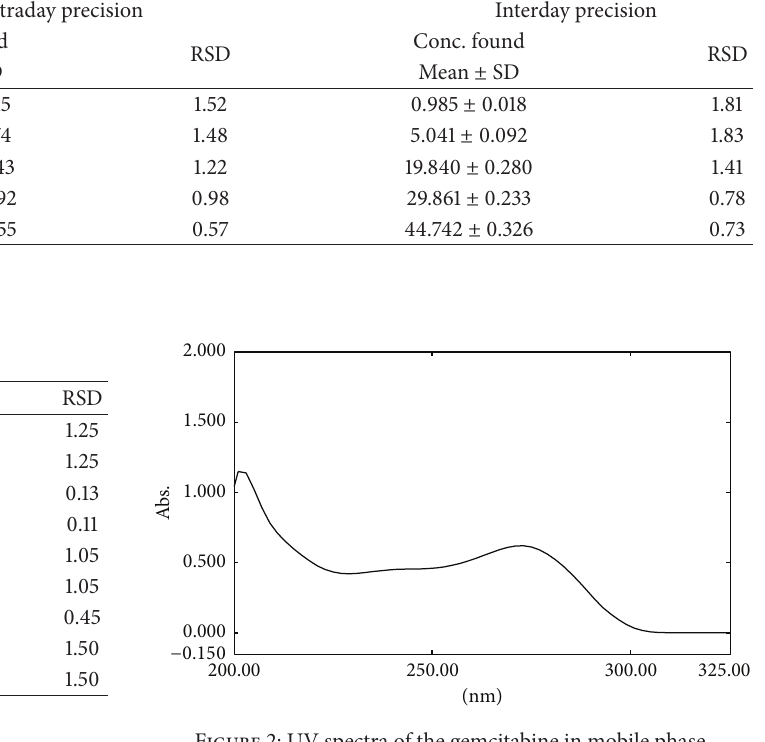
Figure 2: UV spectra of the gemcitabine in mobile phase.